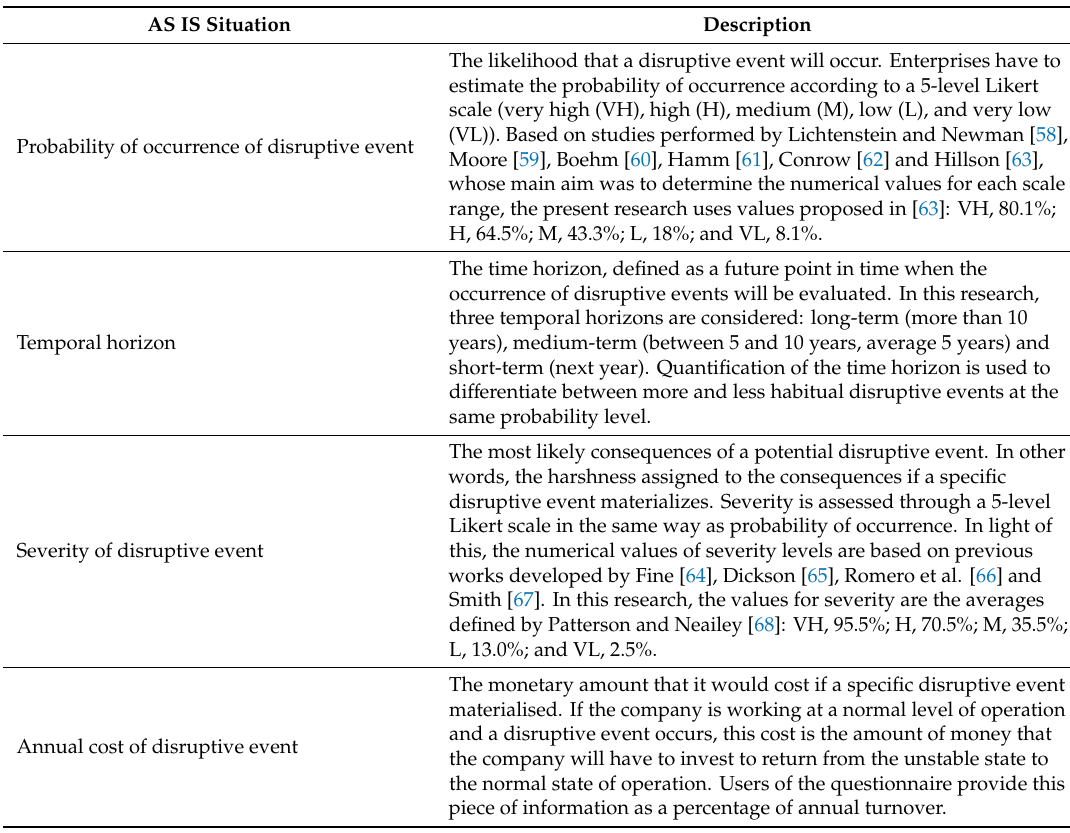
Table 3. Input data required to analyse current (AS IS model) preparedness